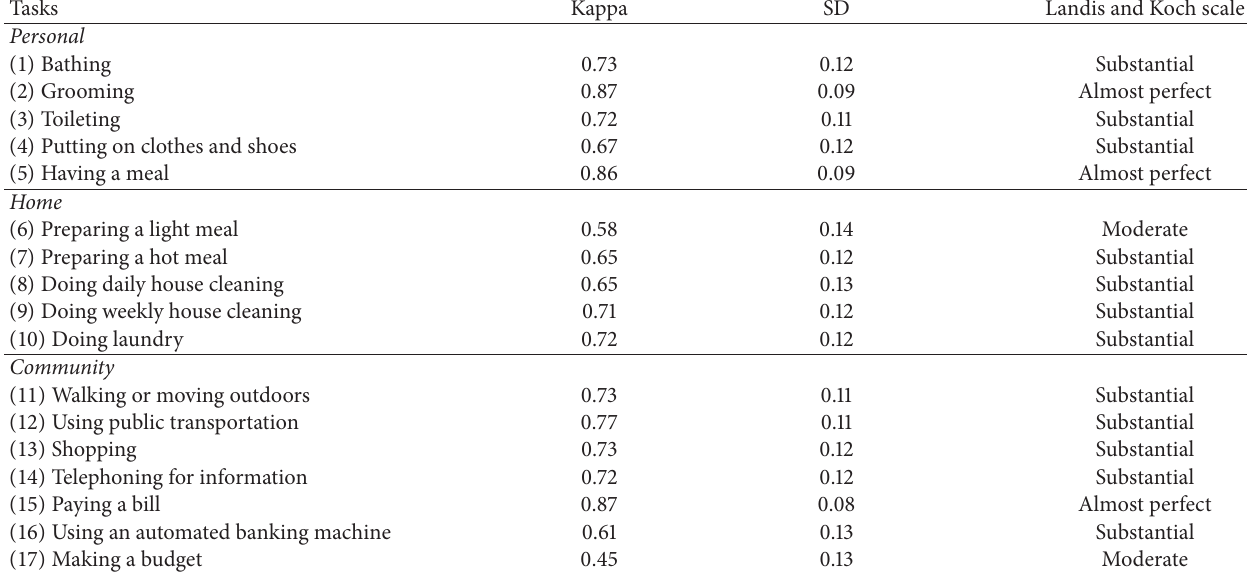
Table 4: Test-retest reliability of the operation of carrying out the task of the ADL Profile.